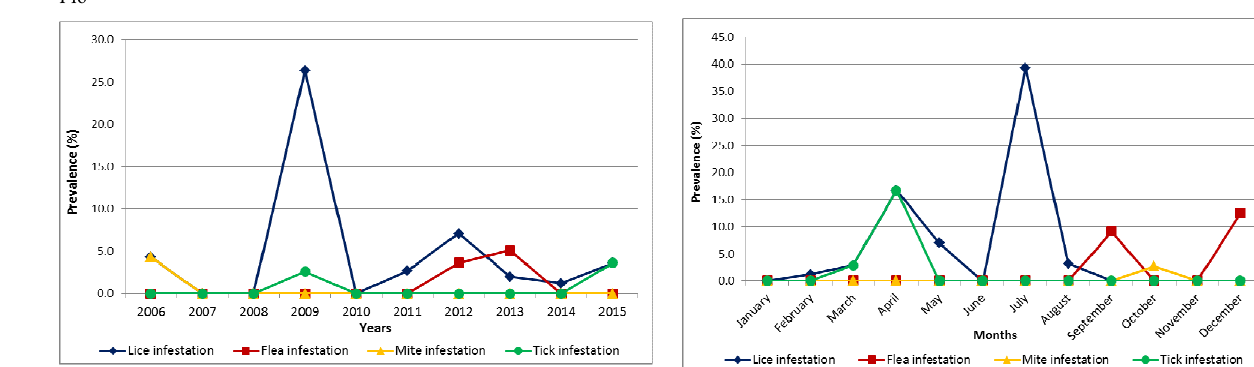
Fig. 1. Yearly prevalence (%) of avian ectoparasitic infestations in the major Veterinary Hospitals in Osun State from 2006- 2015.